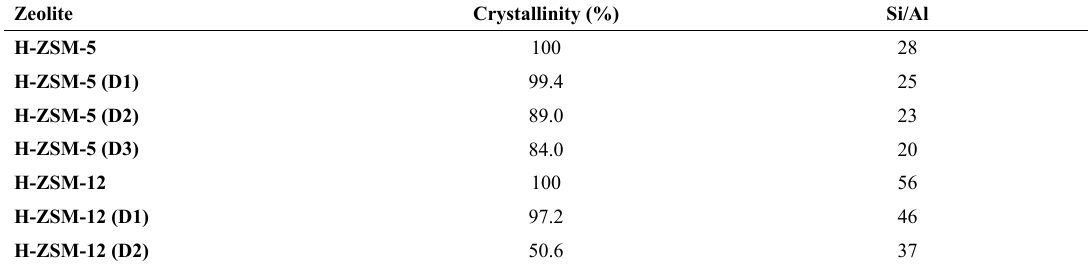
Figure 1. X-ray diffraction patterns before and after desilication. a) H-ZSM-5 and b) H-ZSM-12. Table 2. Crystallinity and Si/Al ratios of the zeolites before and after desilication.